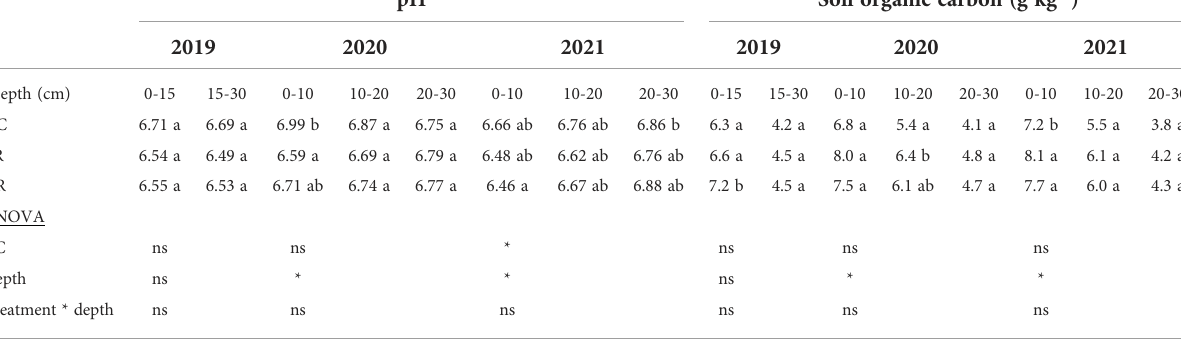
pH Soil organic carbon (g kg -1